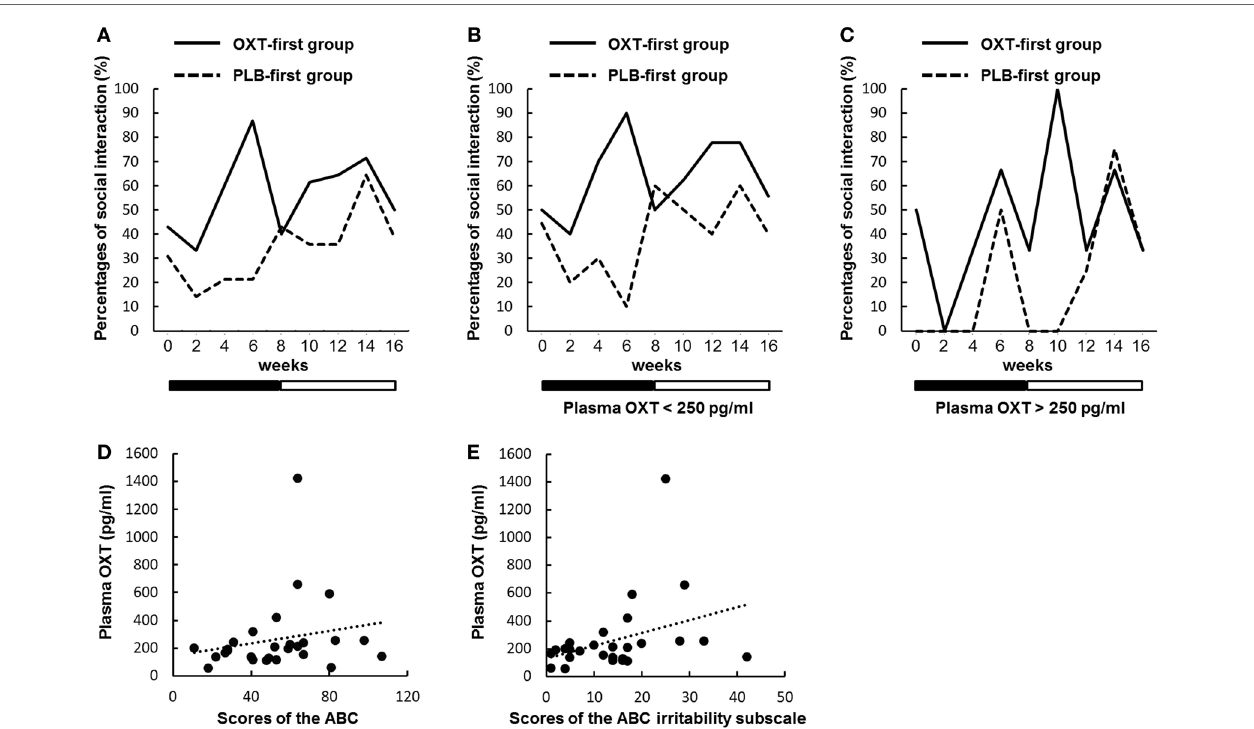
FigUre 4 | sequential changes in the percentages of participants with at least one episode of social interaction. (a–c) Percentages indicate the proportions of all participants who had at least one episode that was regarded as reciprocal social interactions every 2 weeks. Solid and dashed lines indicate the oxytocin (OXT)-first and the placebo (PLB)-first groups. Black and white bars indicate the first treatment period and second treatment period, respectively. (a) There were significant main effects for time and order, but not for treatment ( P = 0.090). However, during the first treatment period, there was a significant main effect of treatment ( P = 0.029). Moreover, there was a significant interaction between treatment and time ( P = 0.041). (B) Sequential changes of episodes regarded as reciprocal social interactions in participants ( n = 20) with plasma OXT concentrations below 250 pg/ml. There were significant main effects for time and order, but not for treatment ( P = 0.109). However, during the first treatment period, there was a significant main effect of treatment ( P = 0.028). Moreover, there was a significant interaction between treatment and time ( P = 0.038). (c) The same as in B, except participants ( n = 7) with OXT concentrations over 250 pg/ml. A generalized mixed regression analysis not including ID showed no significant main effect of treatment ( P = 0.983) during the first treatment period. (D,e) Scatter plots portraying the relationships between plasma OXT concentrations and baseline scores on the Aberrant Behavior Checklist (ABC) (D) and the ABC irritability subscale (e) . The slopes of the dotted linear regression lines indicate a correlation trend [ P = 0.079 (D) ] and a significant correlation [ P = 0.020 (e) ] in all of the